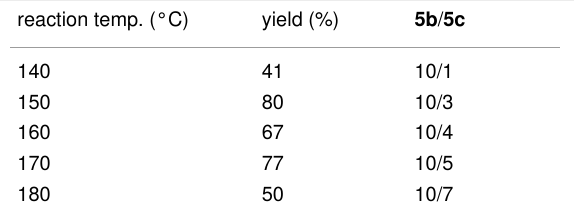
Table 1: The change of 5b / 5c ratio in the product mixture at various temperatures. reaction temp.